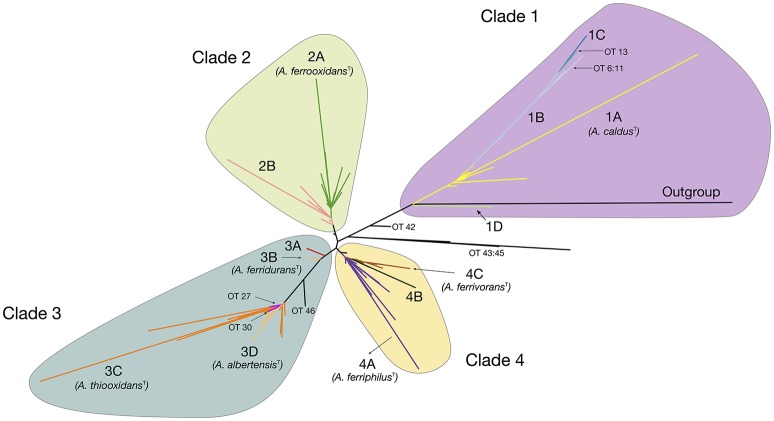
Acidithiobacillus
species complex consensus phylogenetic tree built using maximum likelihood inference and 16S rRNA gene sequences of 580 strains and/or sequence clones. Clade's affiliations are as follows: clade 1 (purple, A. caldusT), clade 2 (green, A. ferrooxidansT), clade 3 (turquoise, A. ferriduransT, A. thiooxidansT, A. albertensisT), clade 4 (yellow, A. ferriphilusT, A. ferrivoransT). Subclades 1A through 4C are color coded according to the oligotype (OT) assigned to the strains and sequence clones that conform each cluster. Minor branches of interest are also shown in the tree and the corresponding OTs indicated. Detailed information on the sequences used in the tree construction and clade assignments can be found in Supplementary Table 3.